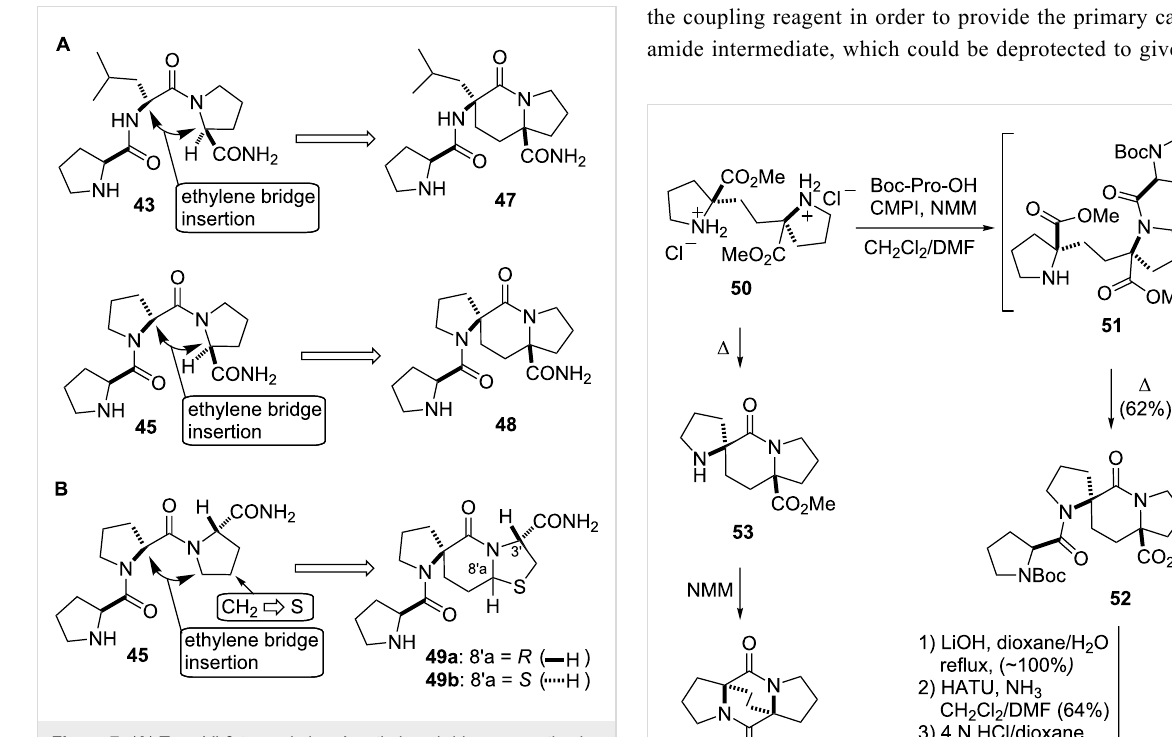
Figure 7: ( A ) Type VI β -turn mimics. An ethylene bridge connection in 43 and 45 between the α -carbon of the second residue and the α -carbon of the C-terminal prolyl residue that is in a cis -amide bond configuration yields spiro-bycyclic PLG peptidomimetics 47 and 48 constrained in a type VI β -turn conformation. ( B ) Polyproline II helix mimics. An ethylene bridge connection in 45 between the α -carbon of the second prolyl residue and the δ -carbon of the C-terminal prolyl residue that is in a trans -amide bond configuration, and the replace- ment of the γ -CH 2 with S yields spiro-bicyclic PLG peptidomimetics 49a and 49b in a polyproline II helix conformation.